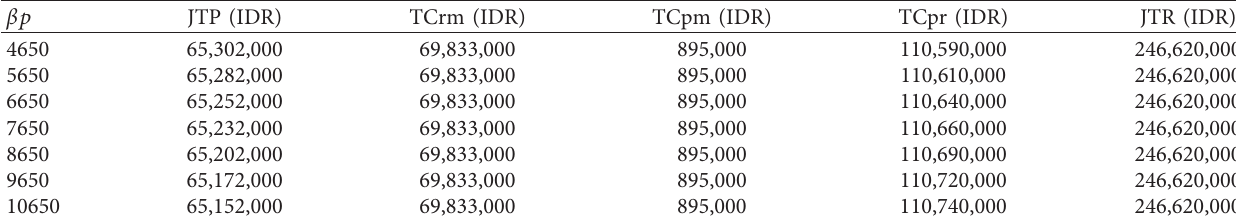
Table 14: Sensitivity analysis of the effect of β p on cost, revenue, and